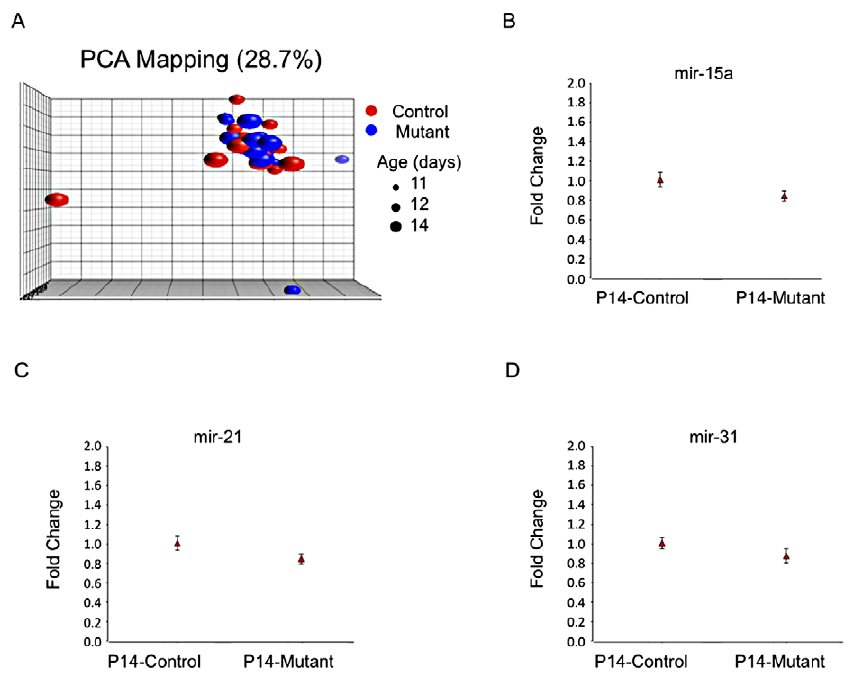
Figure 3. No evidence for distinct microRNA expression patterns. A) PCA plot of microRNA expression covariance matrix showing absence of clustering according to mutant- or age-specific patterns (microRNAs in Table S7). B to D) Plots of fold-change (to control) of RT-PCR data showing similar expression levels of mir-15a (B), mir-21 (C) and mir-31 (D; P14 control kidneys: 5 samples, 4 replicates each; P14 mutant kidneys: 6 samples, 4 replicates each).